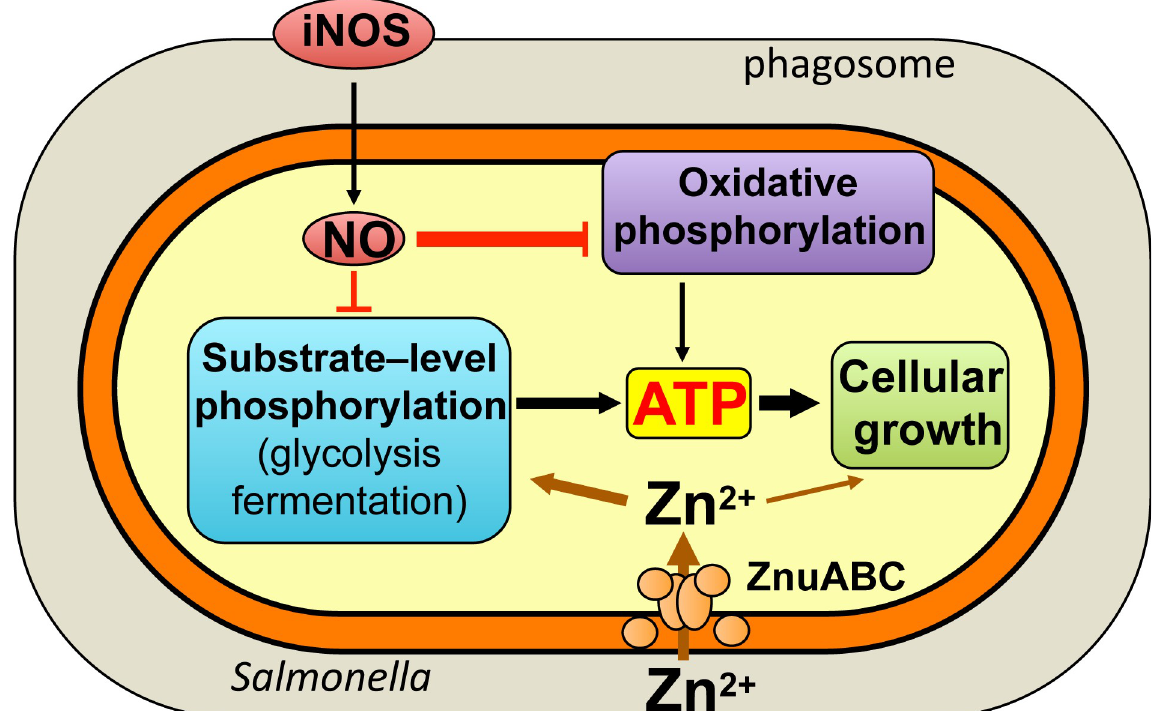
Fig 7. Model for zinc and energy metabolism in the antinitrosative defenses of Salmonella . ATP can be generated by substrate-level phosphorylation in glycolysis and acetate fermentation or oxidative phosphorylation in the electron transport chain. Nitric oxide (NO) produced by iNOS preferentially targets oxidative phosphorylation, and thus most ATP used for growth under nitrosative stress is derived from substrate-level phosphorylation. Zn 2+ acquired through the ABC-type high affinity zinc transport system ZnuABC plays a critical role to the antinitrosative defenses of intracellular Salmonella by enabling fructose bisphosphate aldolase enzymatic activity in glycolysis. The utilization of zinc in multiple cellular processes also adds to the antinitrosative defenses of Salmonella .